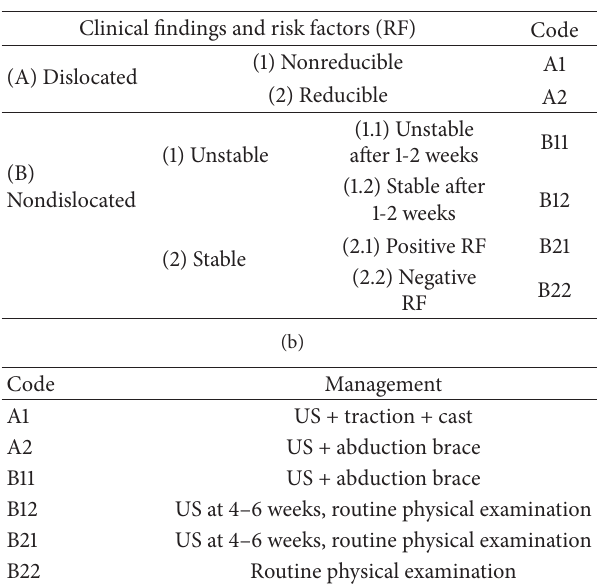
Table 1: Clinical findings: algorithm.